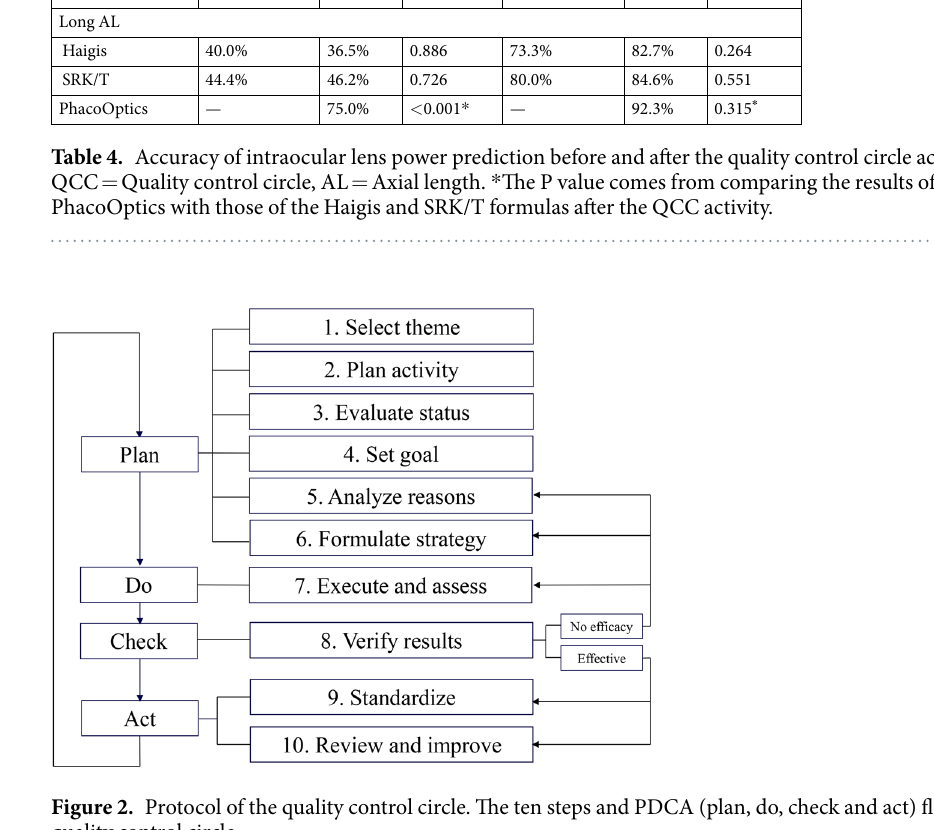
Figure 2. Protocol of the quality control circle. The ten steps and PDCA (plan, do, check and act) flow of the quality control